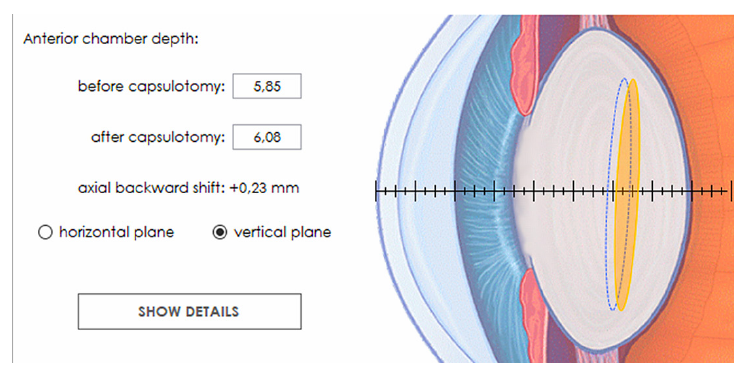
Fig. 3. Graphical visualization of the eye with IOL position and tilt before (blue dashed) and after capsulotomy (filled in yellow).